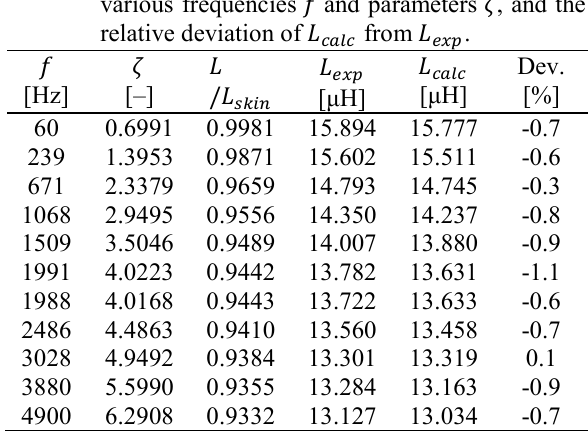
Table 2: The ratio 𝐿/𝐿 𝑠𝑘𝑖𝑛 by equation (11) of a two-wire transmission line at 𝜅 = 3.3699 , the measured ( 𝐿 𝑒𝑥𝑝 ) and calculated ( 𝐿 𝑐𝑎𝑙𝑐 ) total inductances at various frequencies 𝑓 and parameters 𝜁 , and the relative deviation of 𝐿 𝑐𝑎𝑙𝑐 from 𝐿 𝑒𝑥𝑝